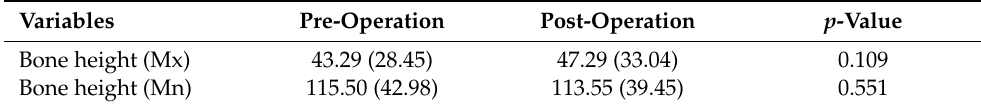
Table 4. Changes in bone height before and after